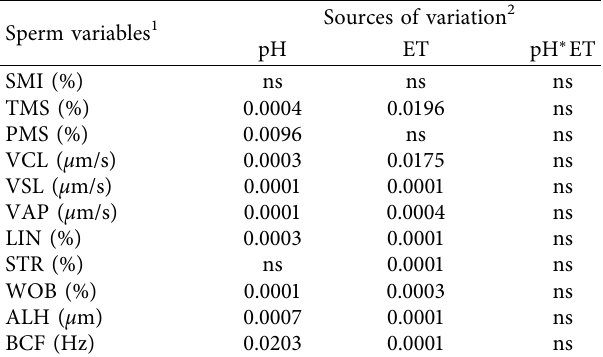
Table 1: Descriptive statistics of semen quality parameters recorded in budgerigars. Semen parameters